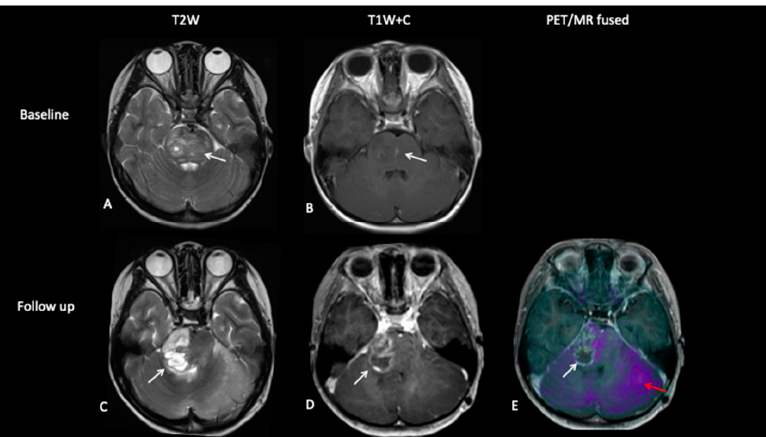
Figure 5. At baseline, there is non-enhancing tumour involving the left basal ganglia ( A,B ) with 8 F- fluorocholine (FCho) and 18 fluoro-L-phenylalanine (FDOPA) avidity ( C ). Follow-up imaging shows residual non-enhancing tumour ( D,E ) reported as stable disease, but FDOPA PET demonstrates reduced uptake ( F ) consistent with metabolic partial response.